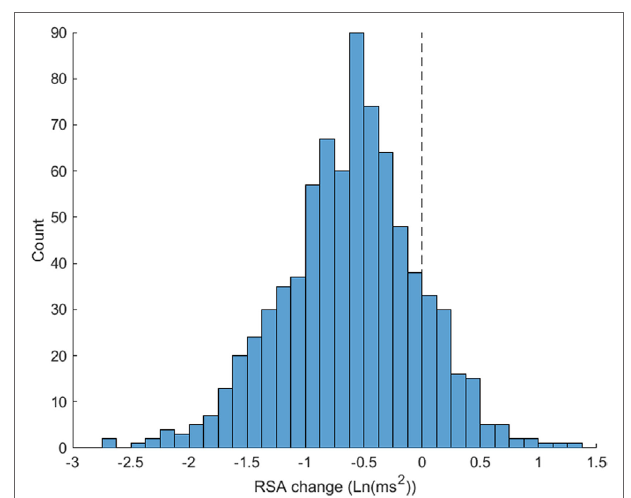
FigUre 3 | Respiratory sinus arrhythmia (RSA) suppression from Soldier Performance and Effective, Adaptable Response (SPEAR) A to B task phases. Distribution of SPEAR task phases A (Scenario description + Video) to B (Response prompt + Adaptability Response) RSA change scores are illustrated. 86% of trials show RSA suppression from A to B phases (number of trials below 0) indicating shifts in autonomic state to meet “Information Receiving” to “Solution Development” requirements of the task.